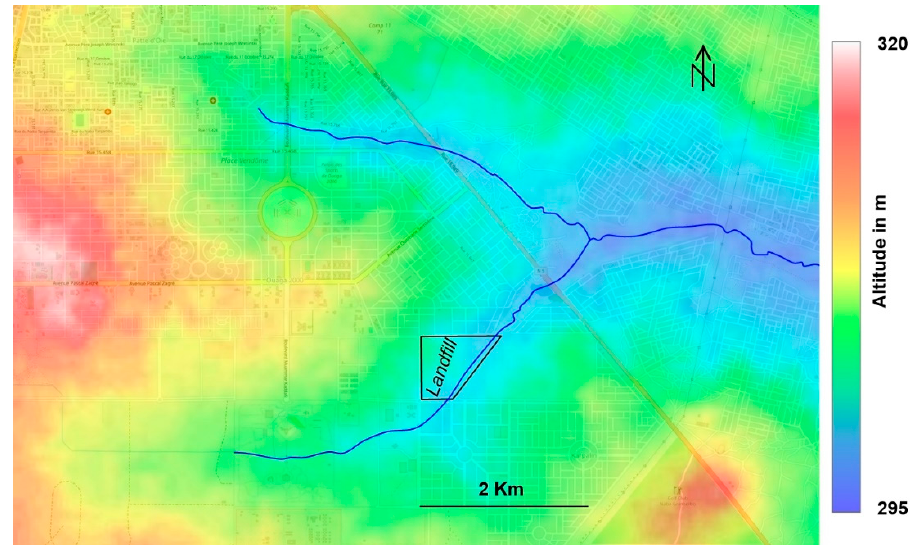
Figure 2. Location of the landfill on the urban background and the topographical framework. Blue lines denote the axis of the major depressions.